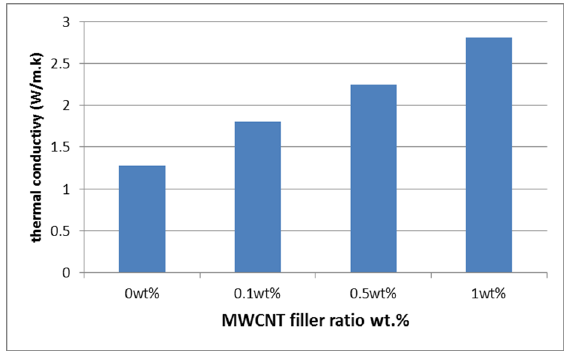
Fig. 10. Thermal Conductivity coefficient